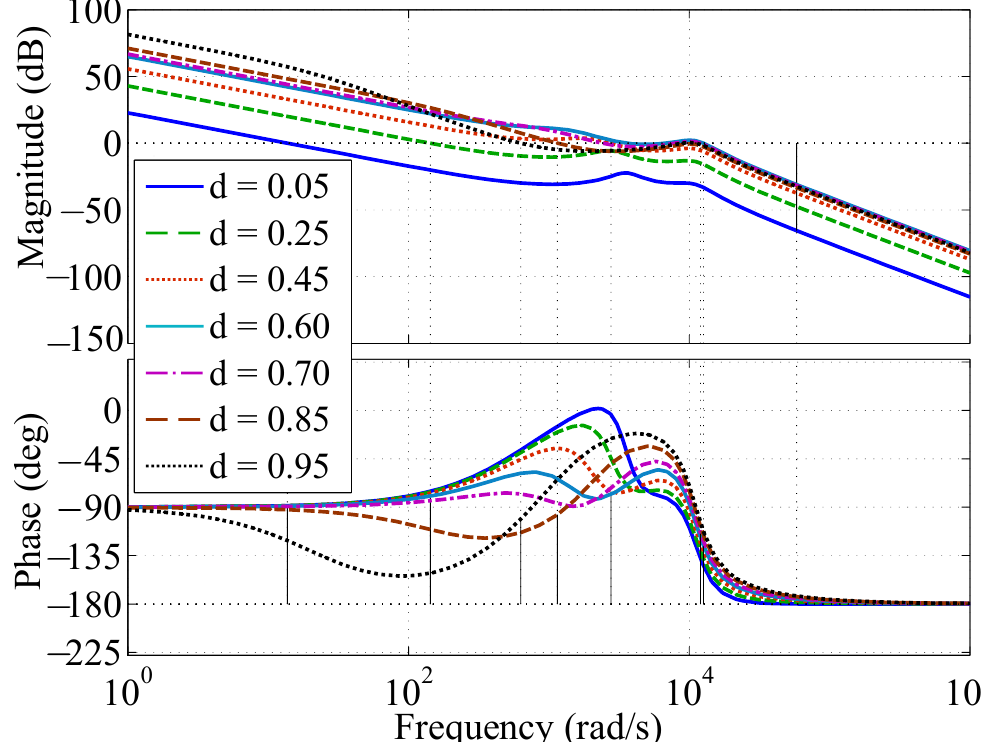
Figure 4. Open loop transfer function of the system is plotted for varying duty ratios with phase margin and gain crossover frequencies marked at STC G = 1000 W/m 2 , T = 25 ◦ C for a single 300 W polycrystalline PV module.